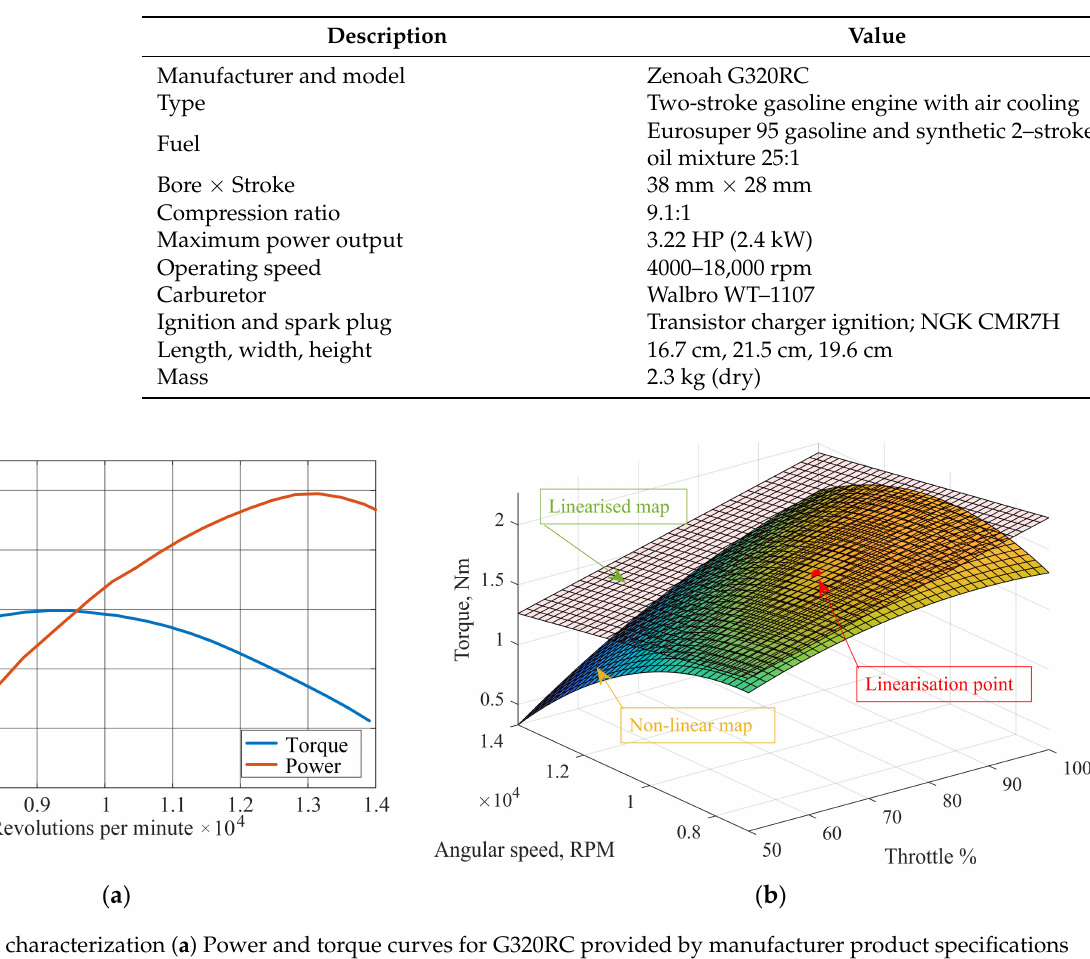
Table 1. ICE engine technical parameters given by the manufacturer.